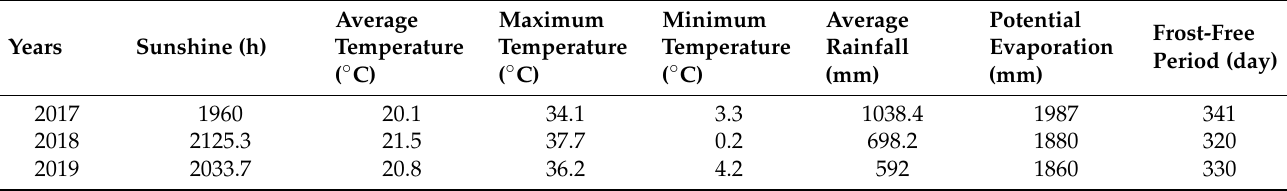
Table 2. Climate data in different